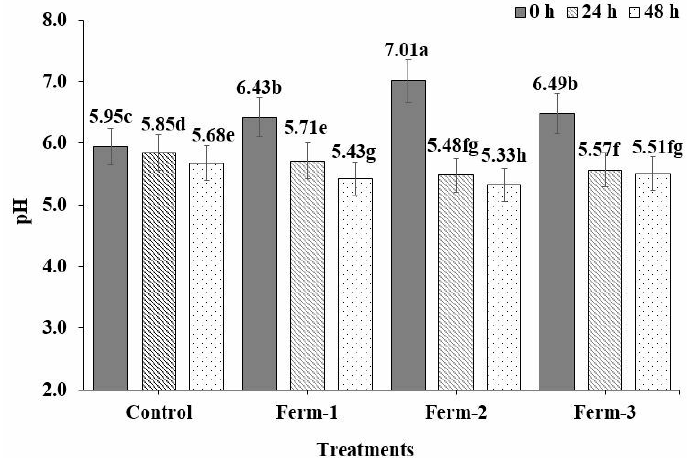
Figure 1. The pH of the solution in which the coffee beans fermented at different hours. The bars with different letters indicate a significant difference ( p < 0.5) among treatments.